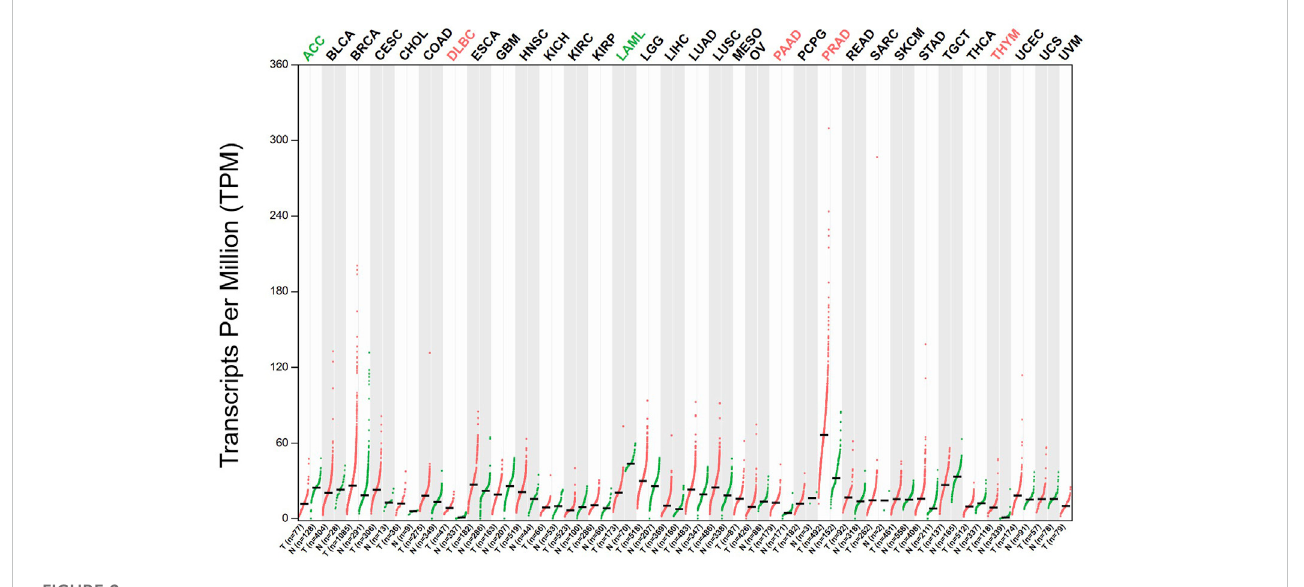
The expression levels of ACC1 in different cancer types have been analyzed by GEPIA